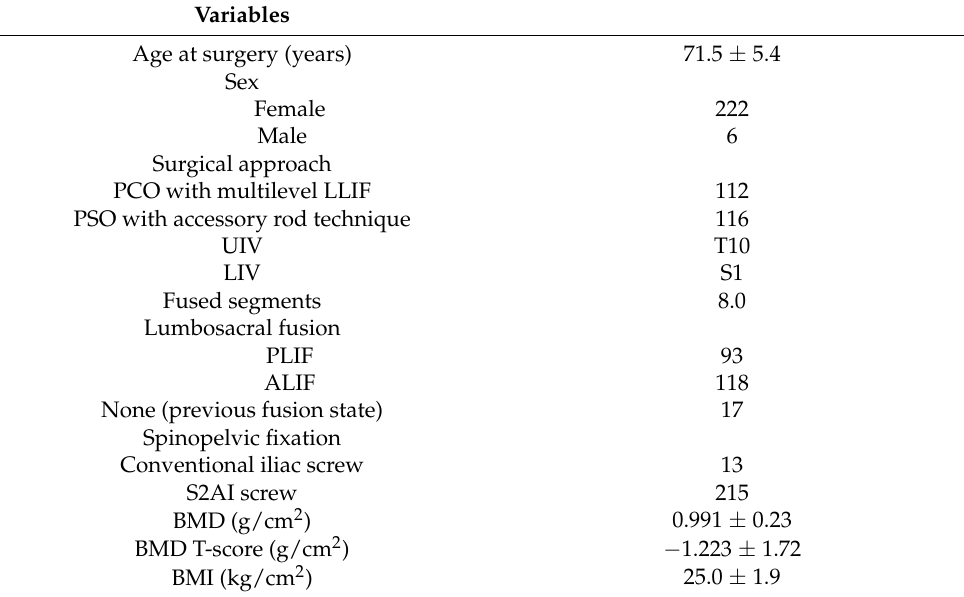
Table 1. Baseline characteristics (228 cases) †